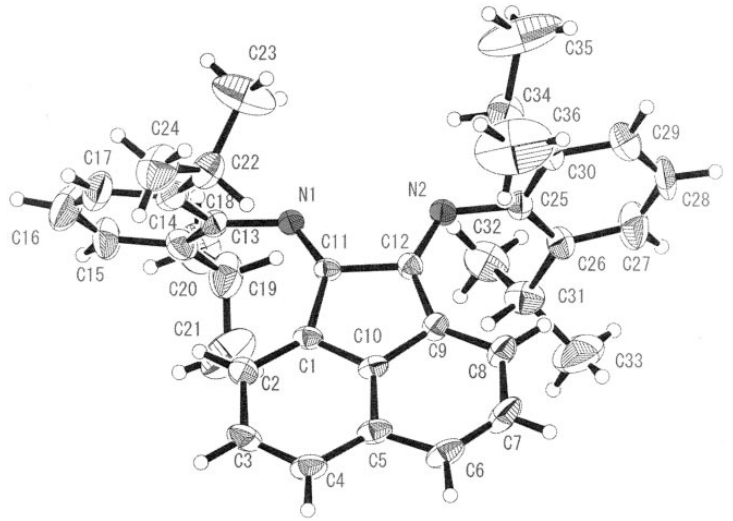
Figure 7. ORTEP representation of Pr-BIAN ligand (adapted from Ref.